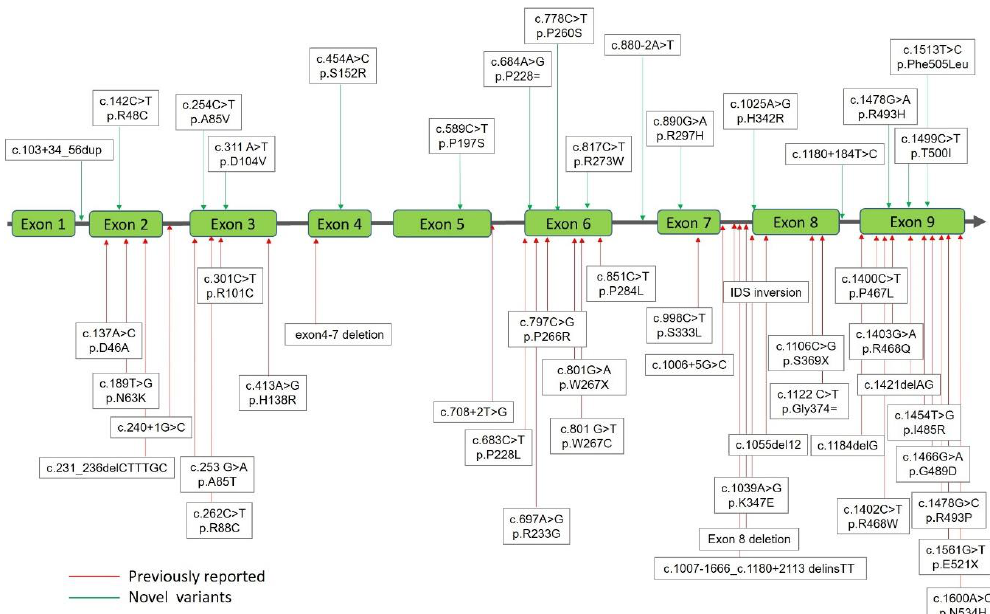
Figure 1. Mutations of the iduronate-2-sulfatase (IDS) gene underlying Taiwanese Hunter syndrome. A total of 51 mutations of the IDS gene underlying Taiwanese Hunter syndrome were found, in those 35 have been reported previously (red lines with arrows) and the other 16 were novel mutations (green lines with arrows).